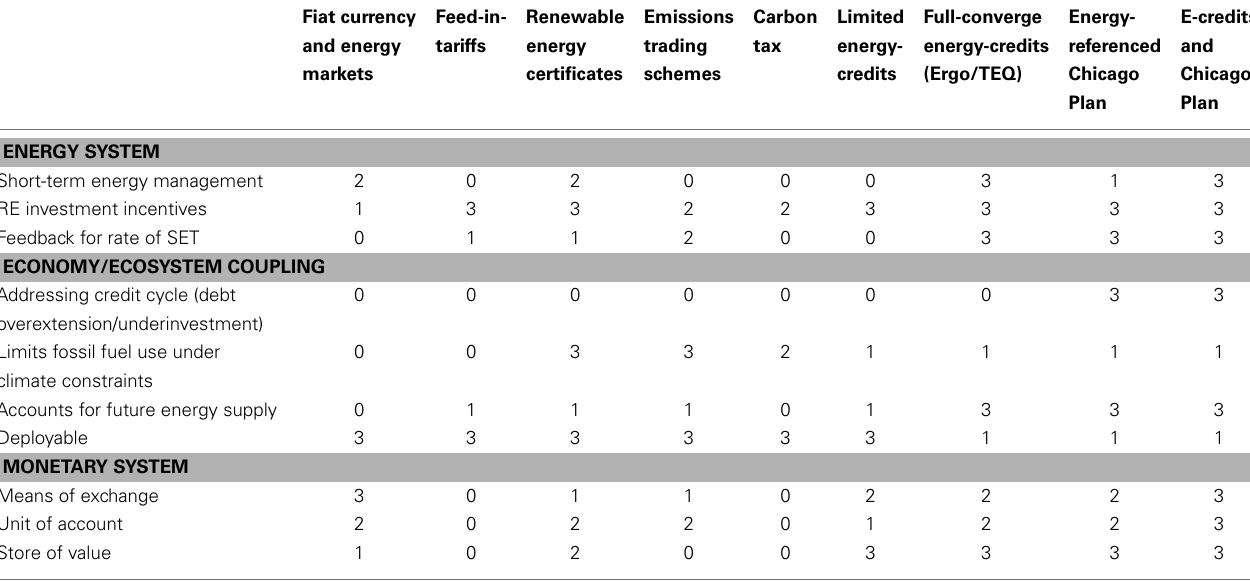
Table 1 | Comparison of sustainable energy transition fit